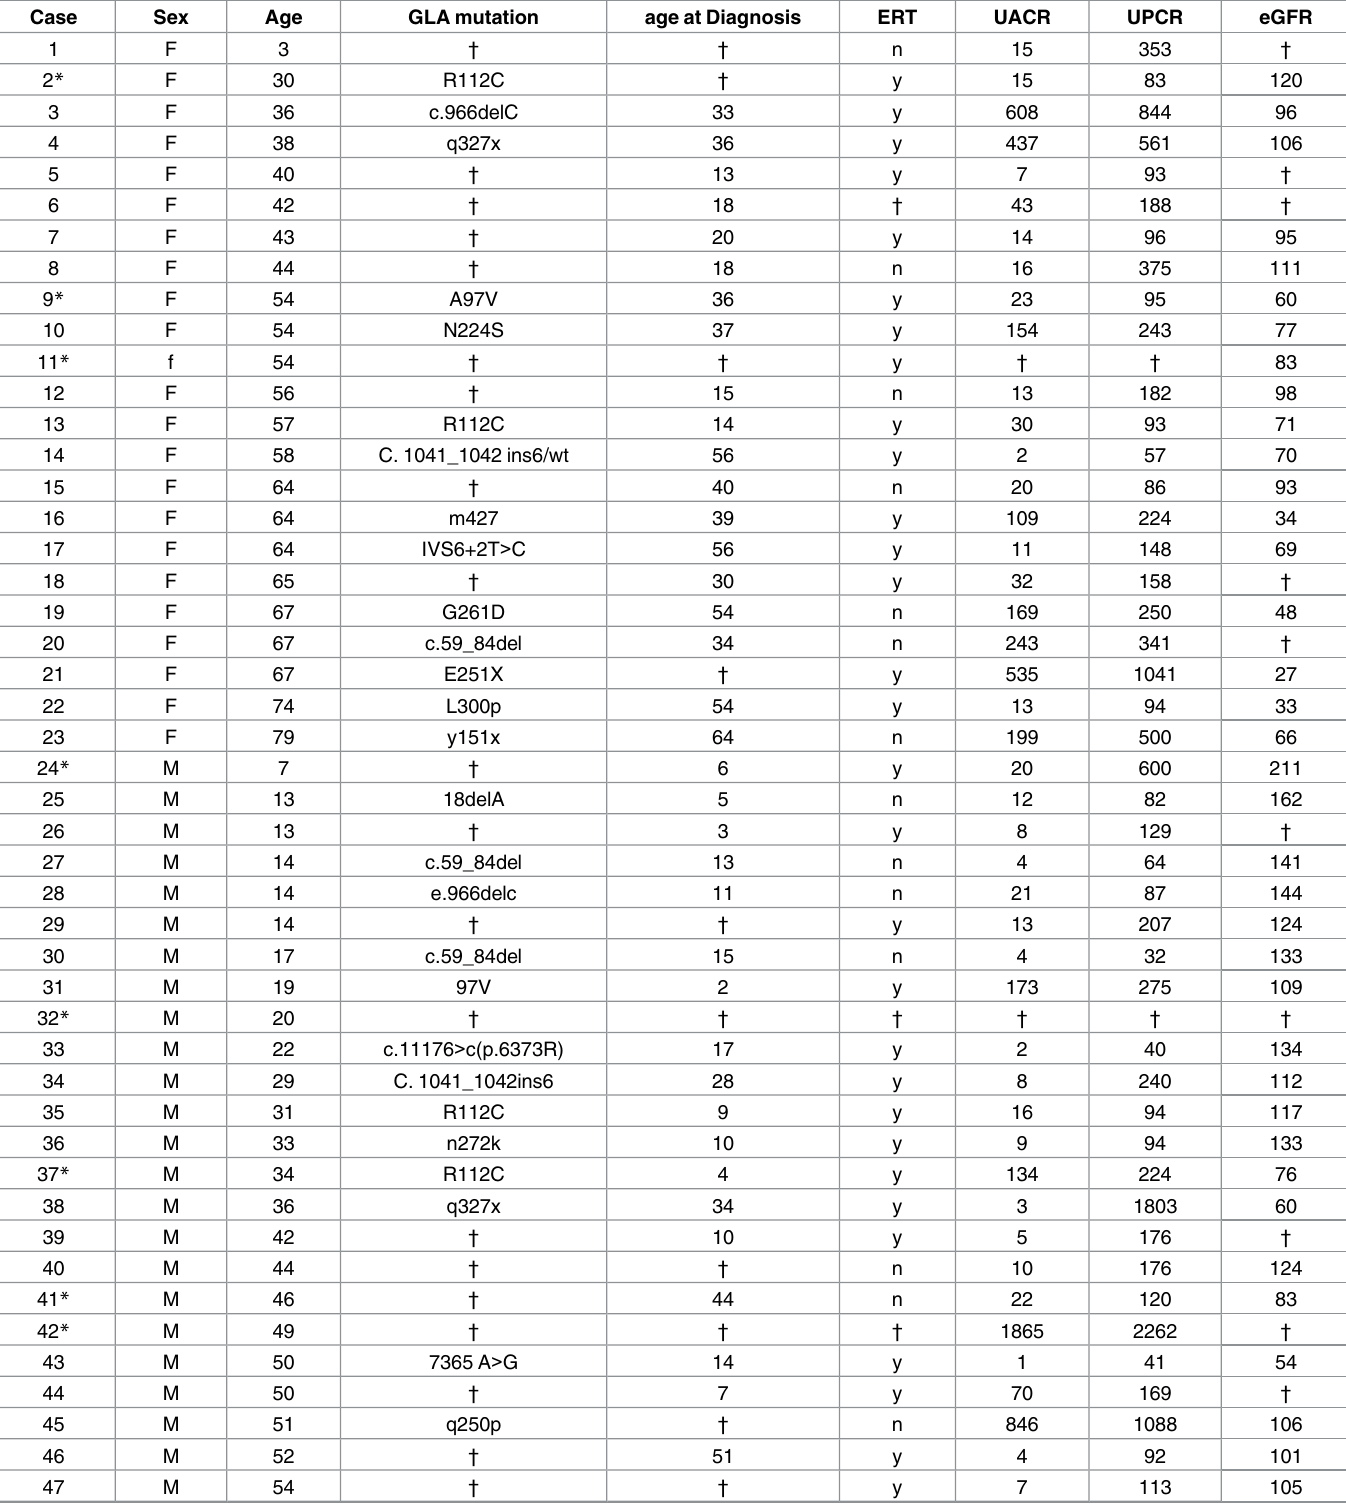
Table 1. Demographics and clinical characteristics of Fabry